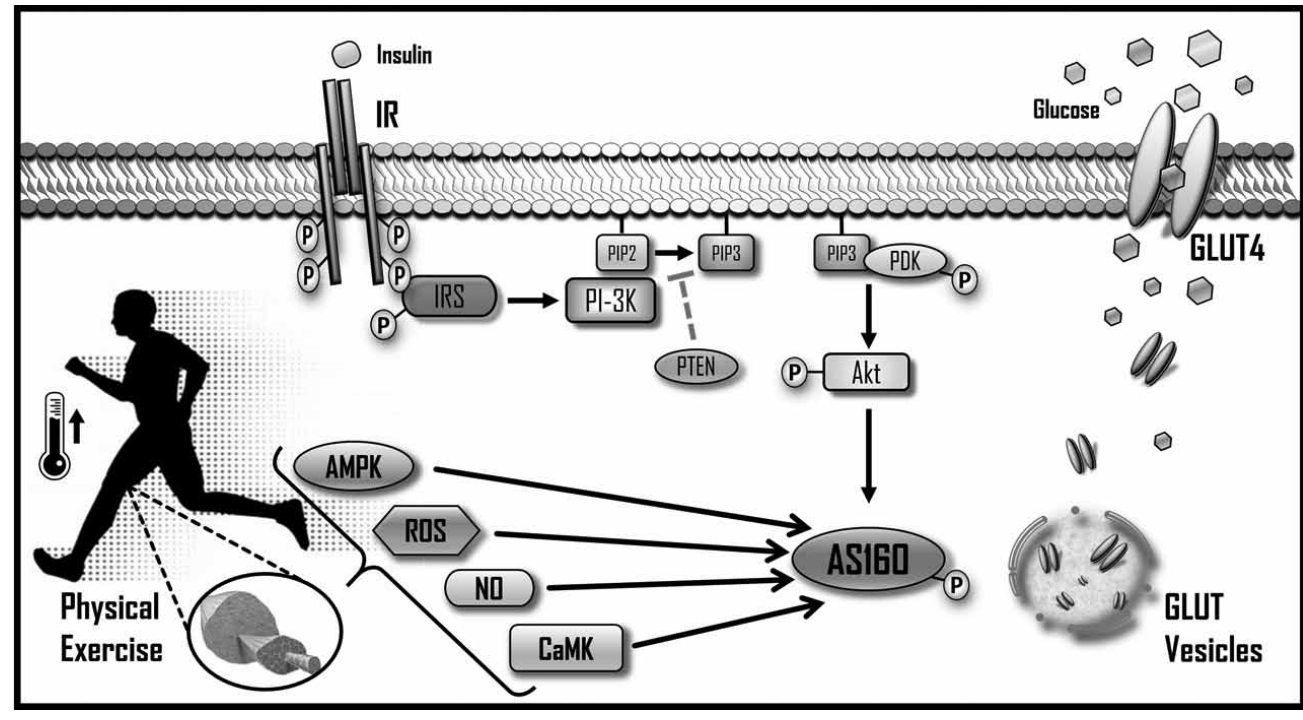
Figure 1. Molecular mechanisms involved in skeletal muscle glucose uptake at rest and in response to exercise. IR, Insulin receptor; IRS, insulin receptor substrate; PI-3K, phosphatidylinositol 3-kinase; PIP2, phosphatidylinositol 4,5-bisphosphate; PIP3, phosphatidylinositol (3,4,5)-trisphosphate; PDK, phosphoinositide-dependent kinase; Akt, protein kinase B; AS160, Akt substrate of 160 kDa; GLUT, glucose transporter; AMPK, AMP-activated protein kinase; ROS, reactive oxygen species; NO, nitric oxide; CaMK, Ca2+/calmodulin-dependent protein